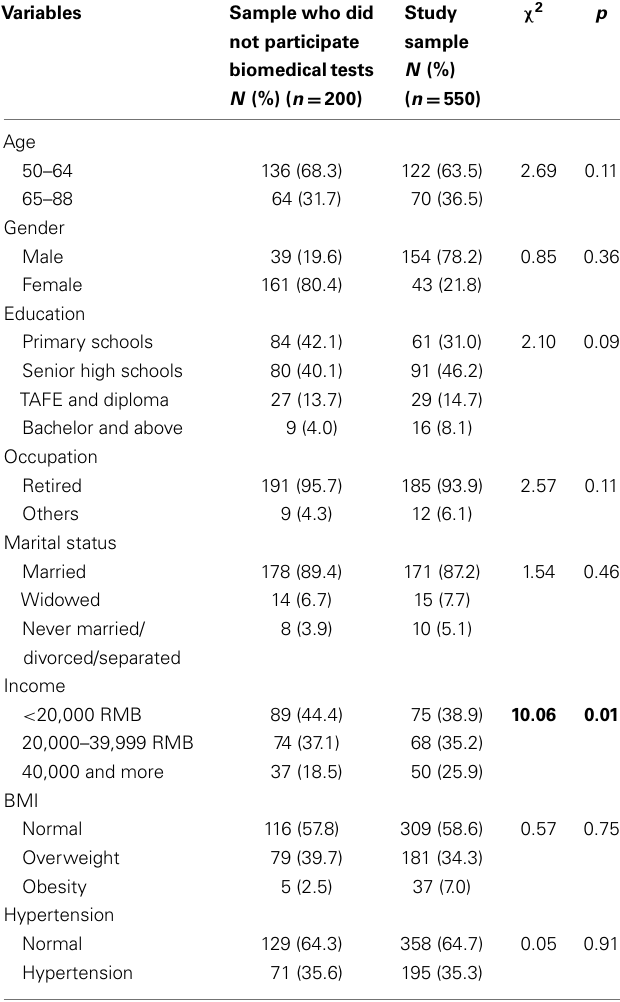
Table 1 | Demographic characteristics of